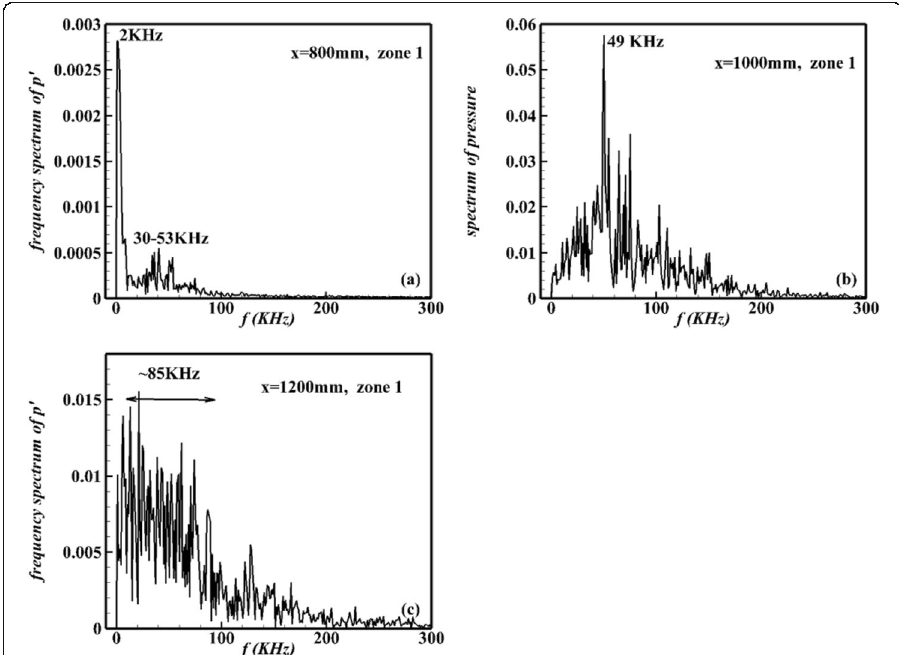
Fig. 16 Spectra of pressure fluctuations of zone 1; ( a ) x = 800 mm, ( b ) x = 1000 mm, ( c ) x = 1200 mm